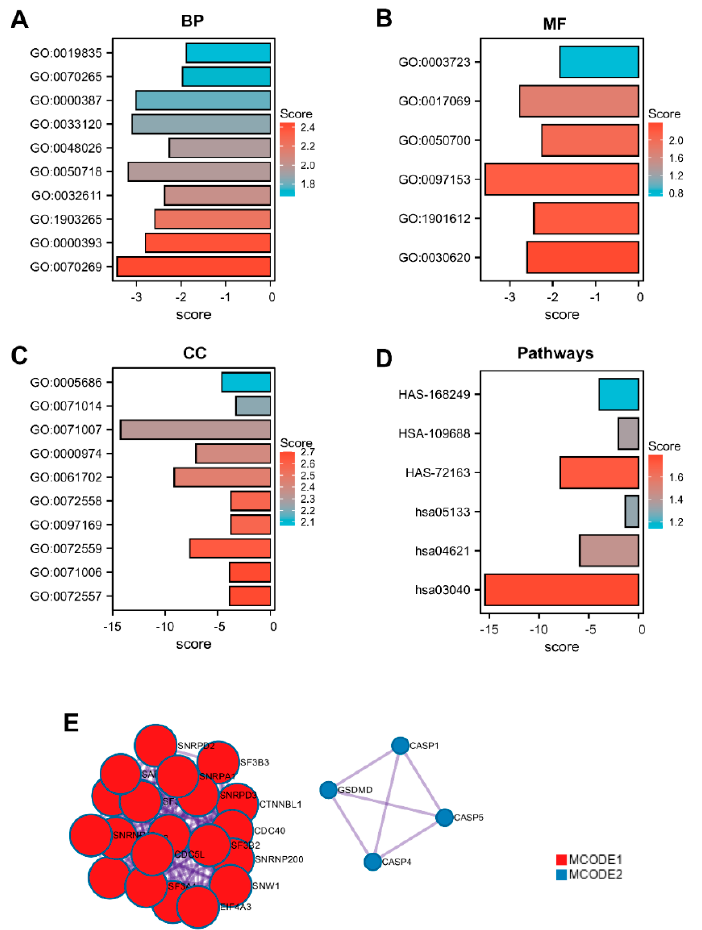
Figure 3. Gene ontology enrichment analysis. Proteins interacting with the GSDM family were screened using STRING (www.string-db.org, accessed on 4 April 2021). GO enrichment analysis significantly distributed GSDM − related genes into ( A ) biological processes; ( B ) molecular functions; ( C ) cellular component categories and ( D ) KEGG pathways prediction. ( E ). Analysis of protein − protein interaction networks was performed in Metascape (http://metascape.org/, accessed on 4 April 2021).